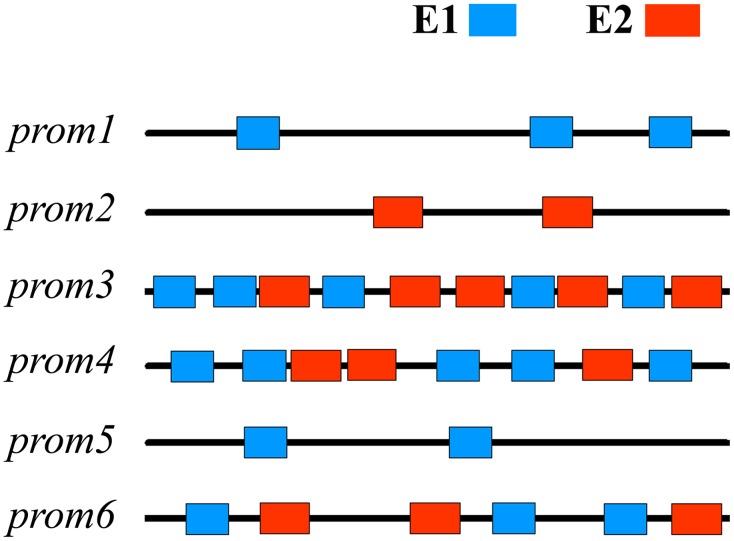
Diagrammatic representation of a pair of CREs (E1, E2) in a set of promoters (prom1, prom2, … prom6).Out of these 6 promoters, 3 contain both the CREs (so, Cprom
E1E2 = 3), 2 contain the first CRE, E1 exclusive to E2 (Cprom
E1¬E2 = 2) and the remaining one contains the second CRE, E2 exclusive to E1 (Cprom
E2¬E1 = 1). Similarly, in the first category of promoters E1 has occurred 13 times and E2 has occurred 11 times (hence, CE1E1E2 = 13 and CE2E1E2 = 11). The number of occurrences of E1 exclusive to E2 is 5 (CE1E1¬E2 = 5) and the number of occurrences of E2 exclusive to E1 is 2 (CE1E2¬E1 = 2). In this case the estimated COR value is 1.77.